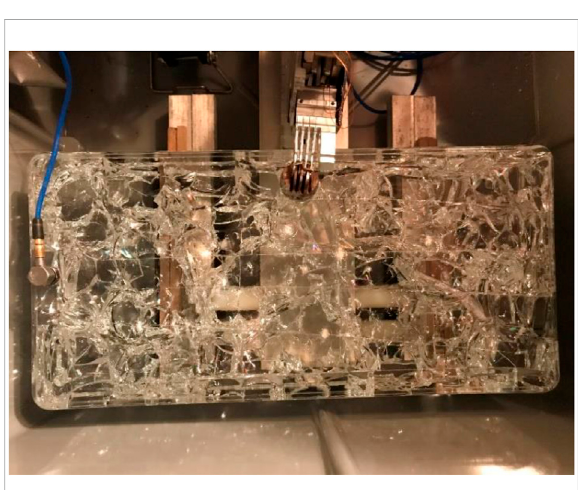
FIGURE 4 Solid soda-lime glass block in thermally shocked damaged state on sequential impact test